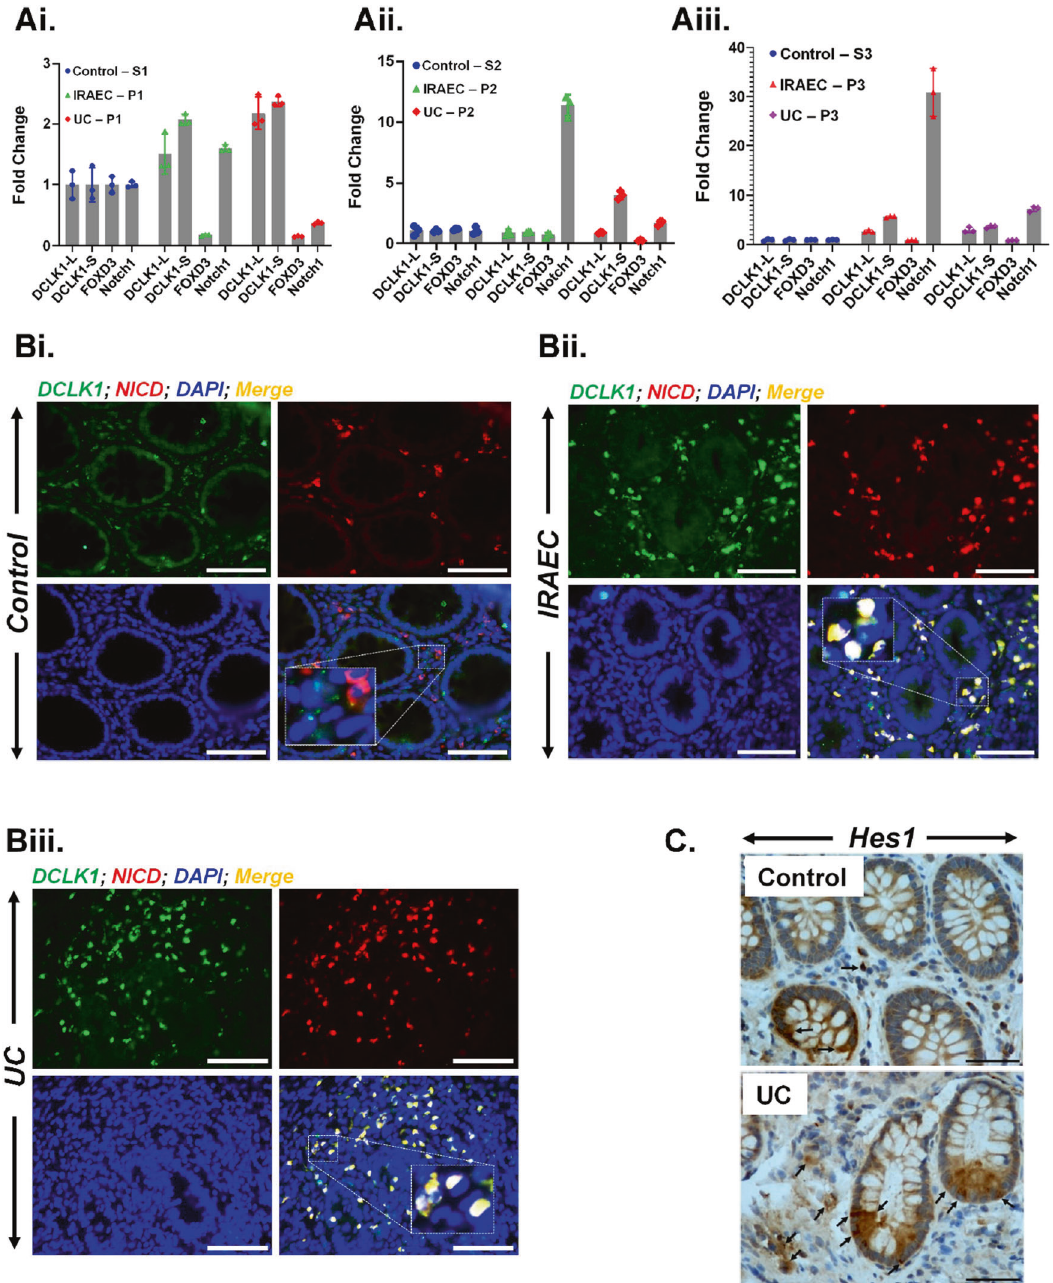
Fig. 1 Correlation of DCLK1 isoforms with components of Notch signaling in the colons of UC and IRAEC patients. A Total RNA from the 10 μ m FFPE sections was isolated followed by real-time RT-qPCR of the indicated markers. The values were normalized to GAPDH and data are presented as fold change. P values for Ai based on signi fi cance (IRAEC): 0.0029 (DCLK1-S), 0.0004 (FoxD3), 0.00016 (Notch1). P values for Ai based on signi fi cance (UC): 0.0042 (DCLK1-L), 0.0011 (DCLK1-S), 0.0003 (FoxD3), 0.00003 (Notch1). P values for Aii based on signi fi cance (IRAEC): 0.014 (FoxD3), 00004 (Notch1). P values for Aii based on signi fi cance (UC): 0.00013 (DCLK1-S), 0.000053 (FoxD3). P values for Aiii based on signi fi cance (IRAEC): 0.0015 (DCLK1-L), 0.000008 (DCLK1-S), 0.00044 (Notch1). P values for Aiii based on signi fi cance (UC): 0049 (DCLK1-L), 0.00019 (DCLK1-S), 0.043 (FoxD3), 0.000029 (Notch1); n = 3 independent experiments. B Paraf fi n-embedded sections from control or immune- mediated colitis (IRAEC) and ulcerative colitis (UC) patients were co-stained with antibodies for DCLK1 and NICD, respectively. Signi fi cant co- localization of DCLK1 with NICD was recorded in the sub-mucosal (stromal) regions in the colons of IRAEC ( Bii ) or UC ( Biii ) patients compared to control ( Bi ), shown as merged images (insets represent higher magni fi cation of nuclear staining) while a subset of DCLK1 + cells did not co- localize with NICD (green staining). Scale bar = 100 μ m; n = 2 independent experiments. C Representative images showing immunohisto- chemical staining of Hes-1, a downstream target of NICD. Scale bar, 80 μ m; n = 2 independent (Figs. 5B and S1D) and was associated with bacterial dissemination antibody to CR. As is depicted in Fig. 5B, sections from the to the liver (Fig. S1E). These changes were associated with a uninfected colon were negative for CR, while signi fi cant CR signi fi cant increase in C-X-C chemokine motif ligand 1 (CXCL1)/ staining was recorded in the lumen of CR-infected colons. In keratinocyte (in mice) levels in both crypt and crypt-denuded response to CR + DBZ, the CR staining extended into the crypts